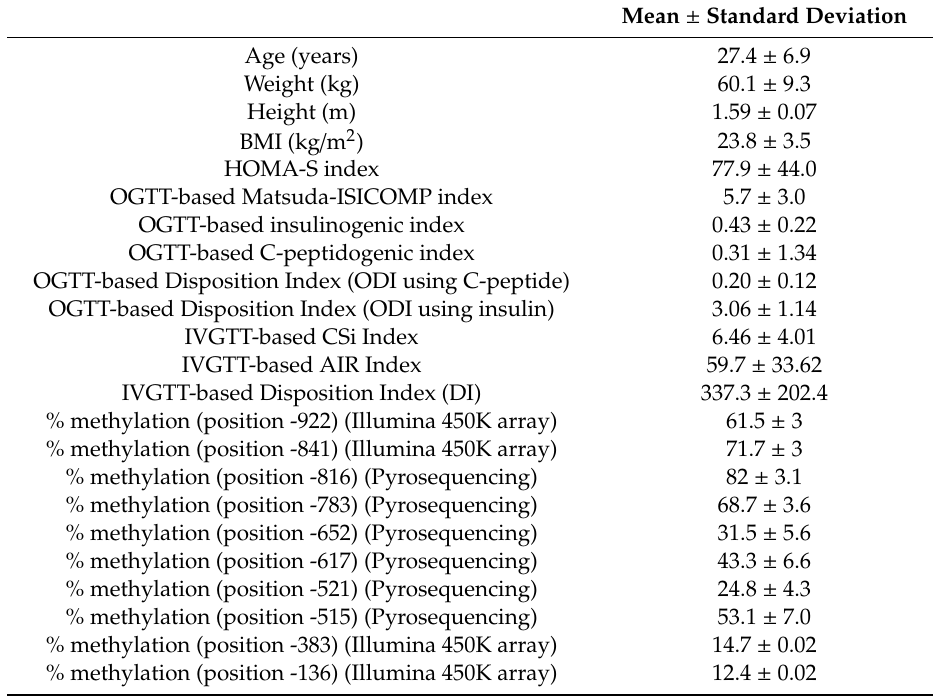
Table 1. Study variables assessed in the non-diabetic Chilean women ( n = 57) of this research.